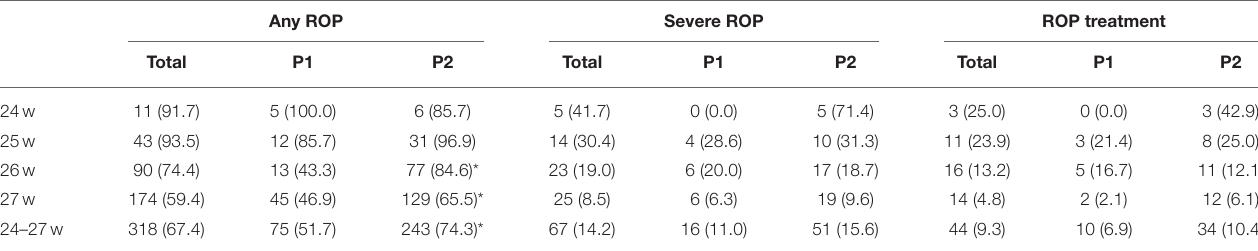
TABLE 3 | Rates of any ROP, severe ROP, and ROP treatment in 472 extremely preterm infants who completed ROP screening in P1 (2010–2014) and P2 (2015–2019) by gestational weeks, n (%).